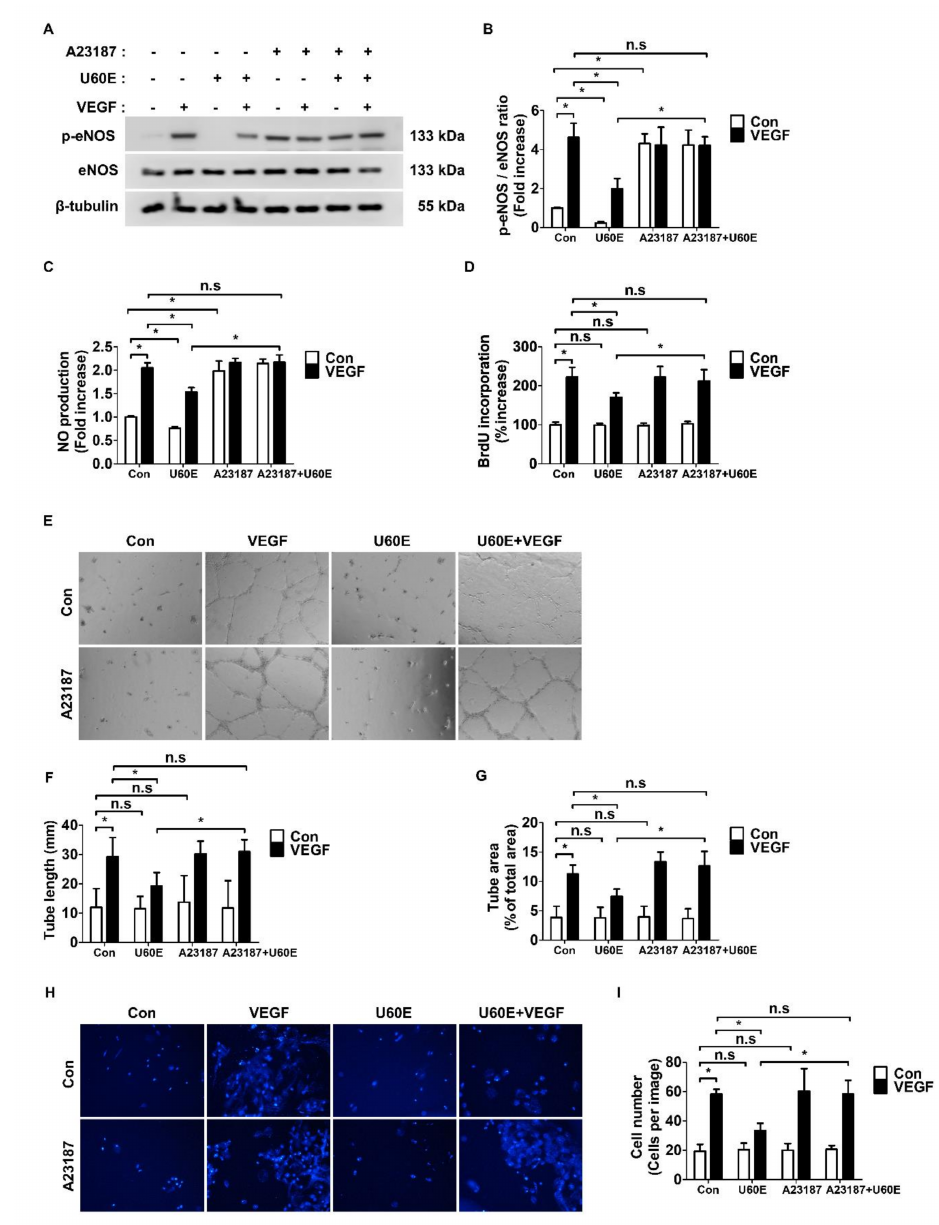
Figure 3. Effects of U60E-mediated decrease in eNOS activation and NO production on angiogenesis. ( A ) HUVECs were treated with VEGF (20 ng/mL), U60E (20 µ g/mL), and/or A23187 (eNOS activator, 5 µ M) for 30 min. The phosphorylation of eNOS (p-eNOS) was determined by Western blot